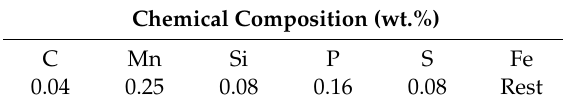
Table 1. Chemical composition of DX51D hot-dip galvanized steels.